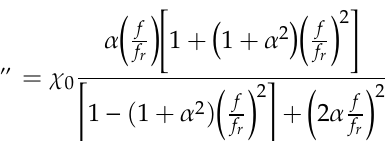
Figure 4. Ferromagnetic resonance (FMR) spectra of FeNi/FeGa (FeGa/FeNi) samples. ( a ) is the FMR image of SA1, SB1 and SC1, ( b ) is the FMR image of SA2, SB2 and SC2.